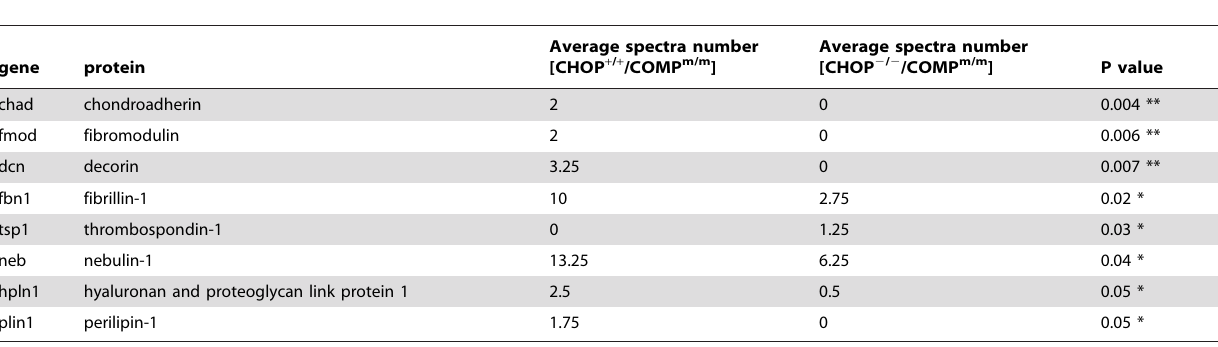
Table 1. Mass spectrometry (LC-MS/MS) of T585M mutant and CHOP wild type [CHOP + / + /COMP m/m ] or knock-out [CHOP 2 / 2 / COMP m/m ] cartilage at 3 weeks of